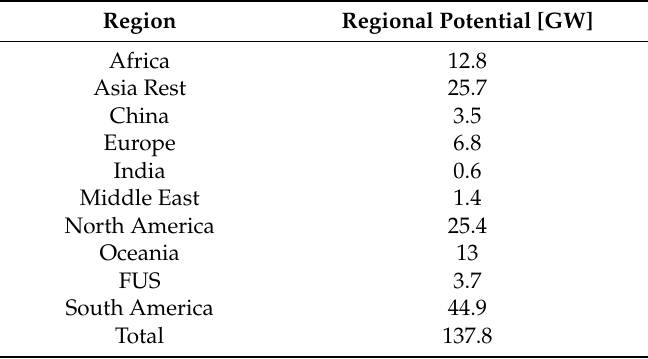
Table 7. Geothermal—Regional